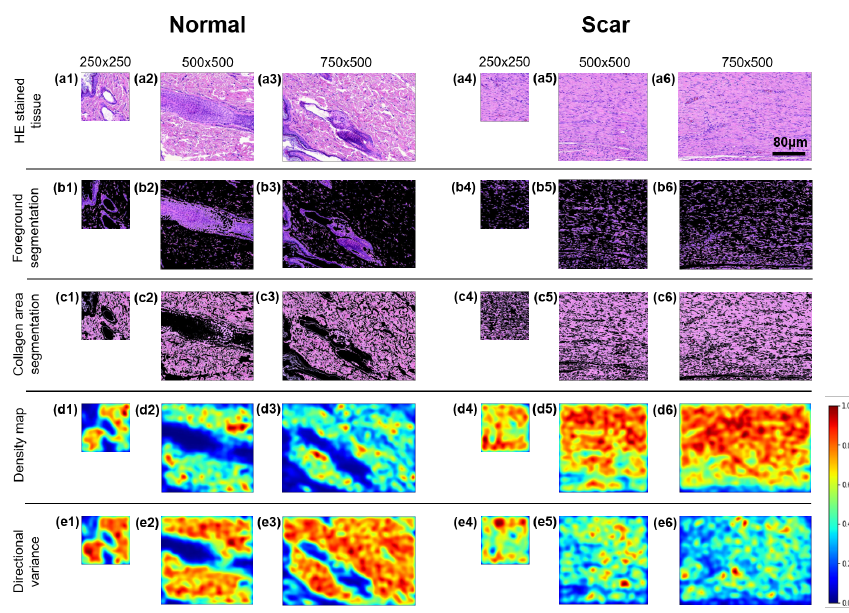
Figure 8. Region of interest (ROI) image comparison between normal (left) and scar tissues (right) in different image sizes (250 × 250, 500 × 500, and 750 × 500 pixels): ( a ) HE-stained tissue (a1–a3 for normal and a4–a6 for scar), ( b ) FS (b1–b6), ( c ) CAS (c1–c6), ( d ) CDM (d1–d6), and ( e ) directional variance map (e1–e6).